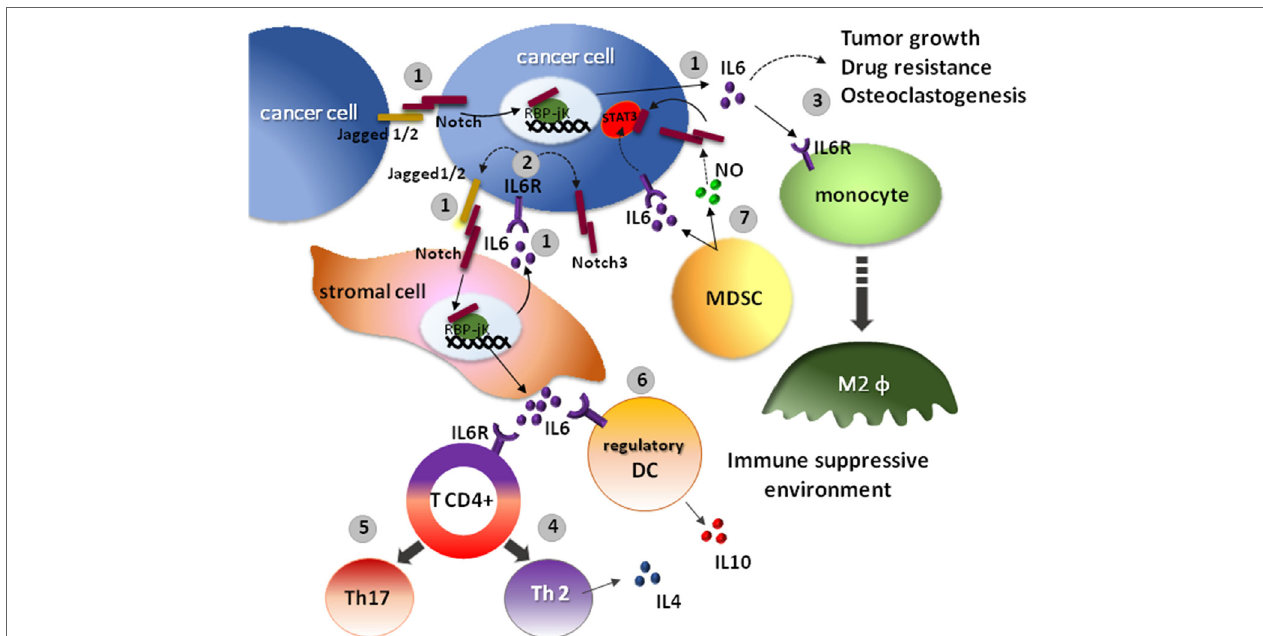
FiGURe 2 | The interplay between IL-6 and Notch affects the anticancer immune response. 1. The overexpression of Notch ligands, Jagged1 and Jagged2 by tumor cells promotes the activation of the Notch signaling in the tumor microenvironment (TME), boosting IL-6 secretion by the same cancer cells and by the neighboring stromal cells (62). 2. On the other hand, IL-6 increases the expression of Jagged1 and Notch3 in tumor cells (64). 3. High IL-6 levels in the TME promote tumor cells growth, resistance to therapy, osteoclastogenesis, and contributes to the development of an immunosuppressive niche. Indeed, the activation of IL-6R on immune cells causes the polarization of M2 macrophages. 4. The differentiation of CD4 + T cells into interleukin 4 (IL-4)-producing Th2 cells. 5. The increased differentiation of pro-inflammatory Th17 cells. 6. The development of interleukin 10 (IL-10)-producing regulatory DCs (65). 7. An alternative source of IL-6 is represented by myeloid-derived suppressor cells (MDSCs). MDSCs support tumor stem cell maintenance by a combined action of IL-6 and nitric oxide (NO). Indeed, MDSCs, through the release of IL-6, promotes the phosphorylation of signal transducer and activator of transcription 3 (STAT3) essential for maintenance of cancer cell stemness, and by producing NO indirectly activates the Notch pathway. Notch activation, in turn, causes prolonged STAT3 activation